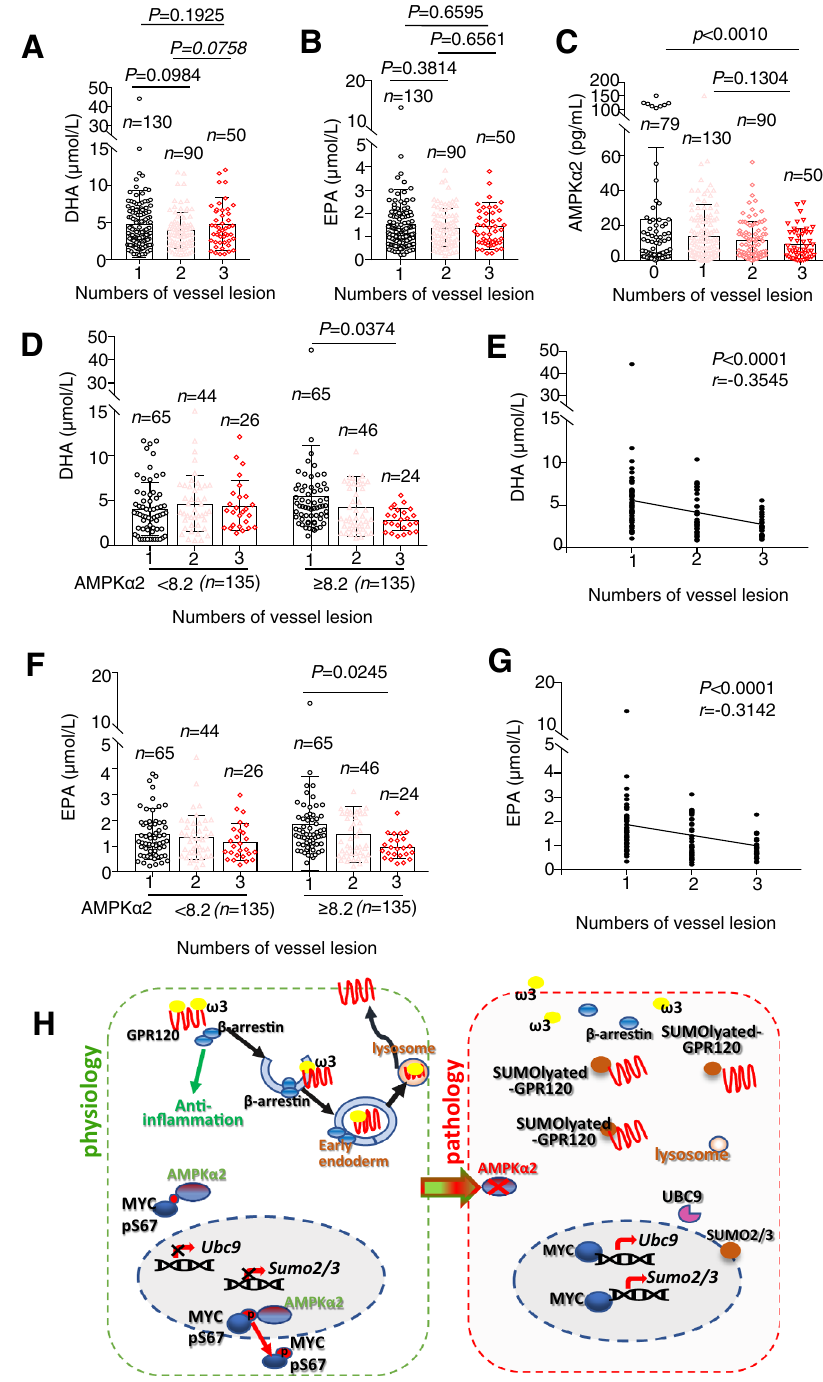
Fig. 7 | AMPK α 2 expression determined the protective effect of FO in CAD patients. PlasmaDHA( A ),EPA( B ),orAMPK α 2( C )inplateletversusCADseverityin 349patientsbasedonvessel-lesionnumbers:0nolesionvesselrepresentnon-CAD, 1 single vessel represents low severity, 2 two vessels represent medium severity, and 3 three vessels represent high severity. Data are presented as the median± s.e.m. and were analyzed by one-way ANOVA with the Kruskal – Wallis test for multiplecomparisons.PlasmaDHA( D )andEPA( F )concentrationsinCADpatients and vessel-legion numbers versus AMPK α 2 activation in platelet-rich plasma. A grayscale value of <8.2pg/mL for IP assay obtained AMPK α 2 activation indicates lowAMPK α 2activityandavalueof ≥ 8.2indicateshighAMPK α 2activity. p valuevia